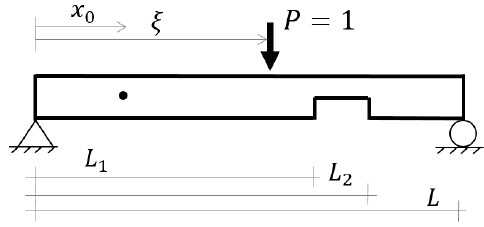
Figure 3. Determinate beam in Example-I.